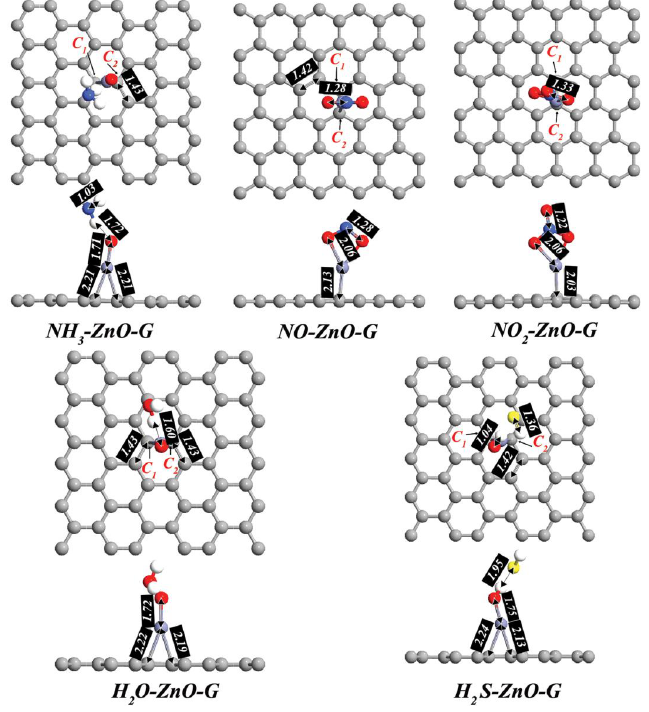
Figure 3. The most stable adsorption configurations (top and side view) for NH 3 , NO, NO 2 , H 2 O, and H 2 S on the ZnO–graphene sensor. The gray, purple, red, blue, yellow, and white balls represent C, Zn, O, N, S, and H atoms, respectively. The bond lengths (in unit of Å) and the binding distances between the molecule and the sensor are also